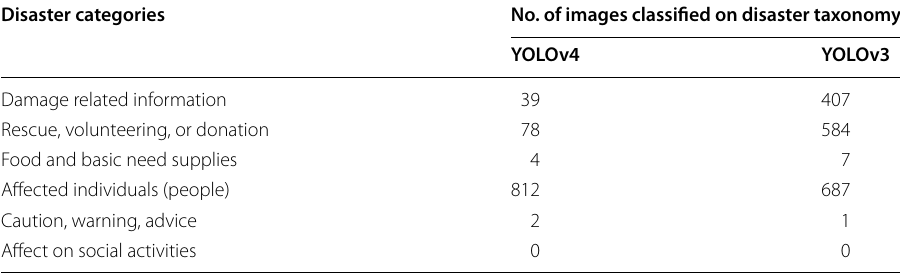
Table 9 Comparison of YOLOv4 and YOLOv3 classification results on emergency response taxonomy on combined custom and COCO dataset Disaster